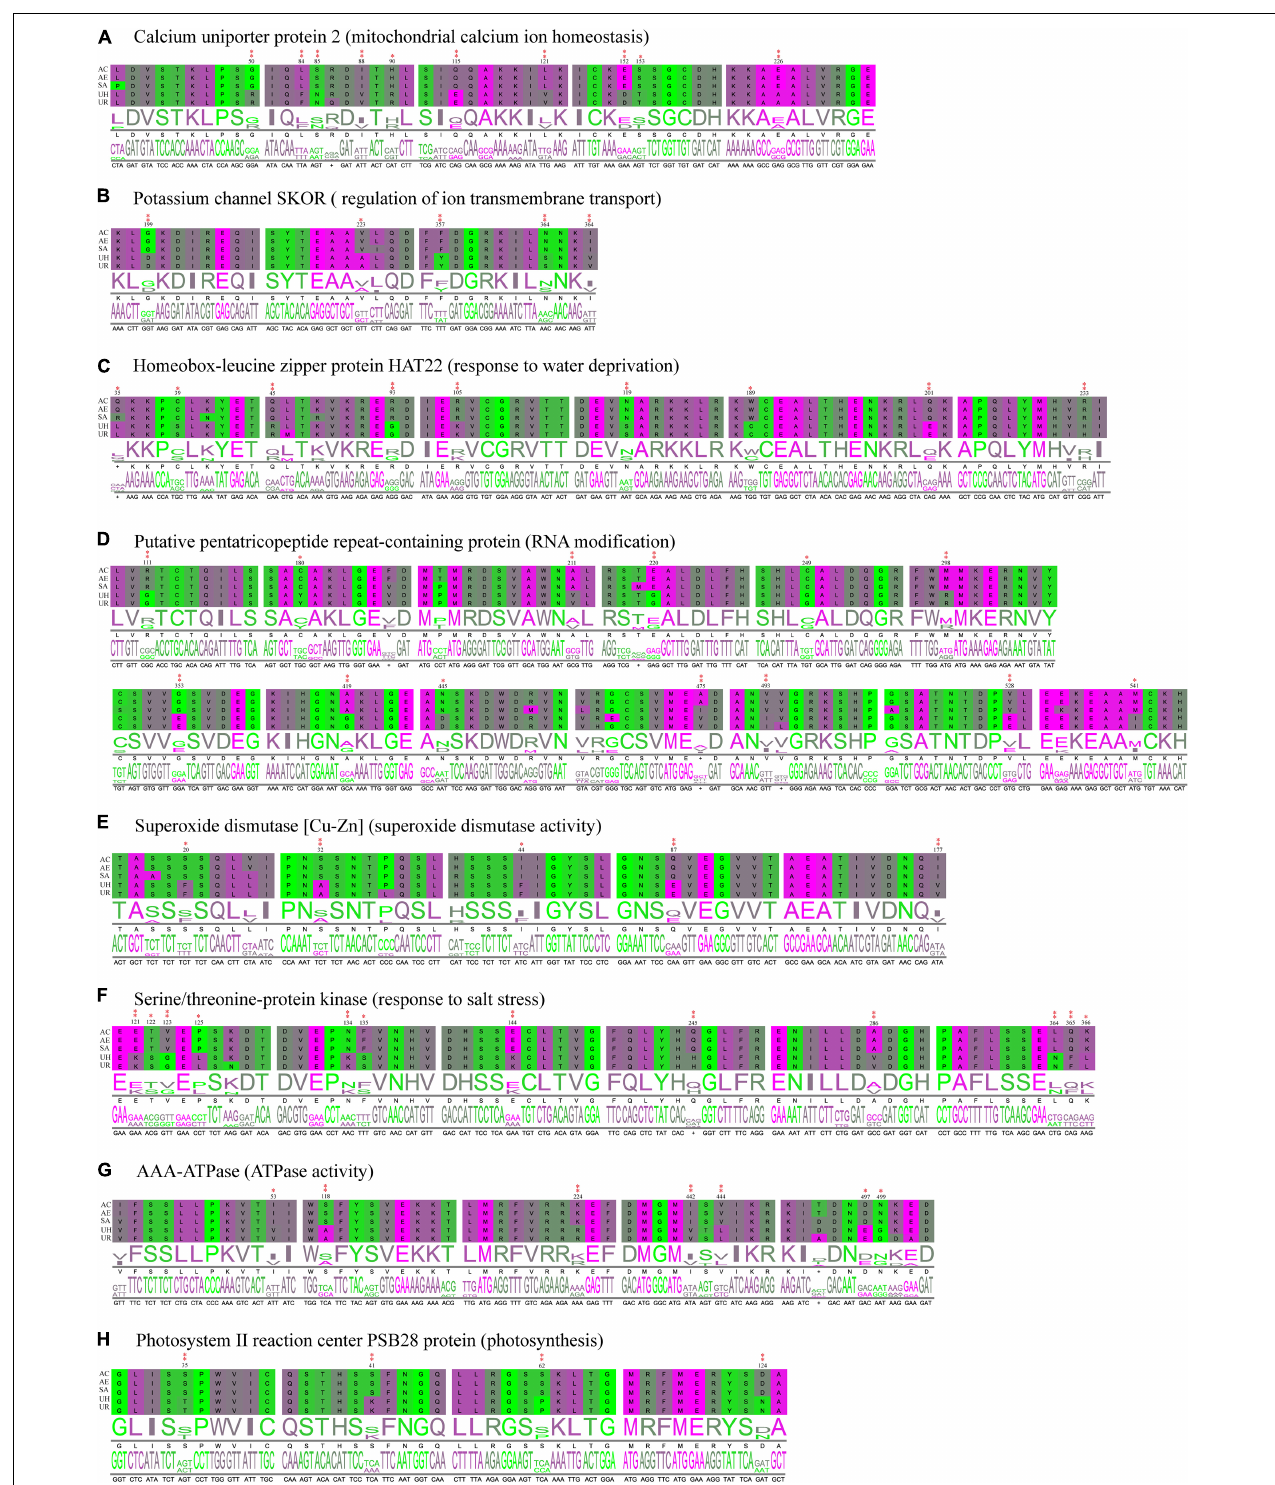
FIGURE 8 | Partial alignment of some positively selected genes. (A–C) Positively selected genes (PSGs) related to transmembrane transport, ion homeostasis and water retention. (D) PSGs related to genetic information process. (E,F) PSGs related to the stress response. (G,H) PSGs related to photosynthesis and energy metabolism. Double red asterisks in the top stand for the amino acids is a positively selected site with a BEB posterior probability of more than 0.95, and one asterisk stands for the sites with a posterior probability larger than 0.90, but lower than 0.95. Numbers at the base of the asterisks stand for the site position in the PSGs. (AC, A. coerulea ; AE, A. ecalcarata ; SA, S. adoxoides ; UH, U. henryi and UR, U. rockii ).